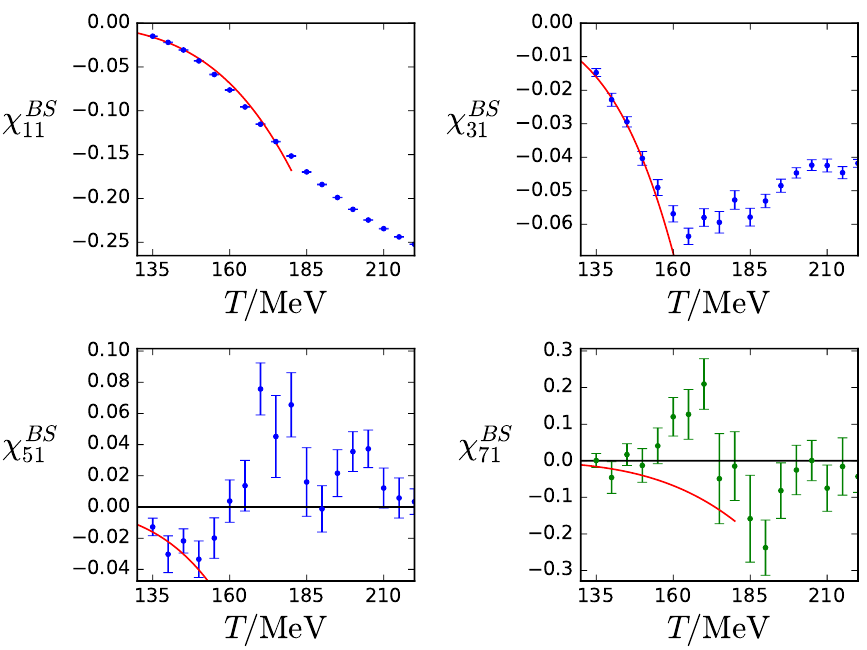
Figure 5 . (cid:31) BS ; (cid:31) BS ; (cid:31) BS and an estimate for (cid:31) BS 11 31 51 curves are the HRG model